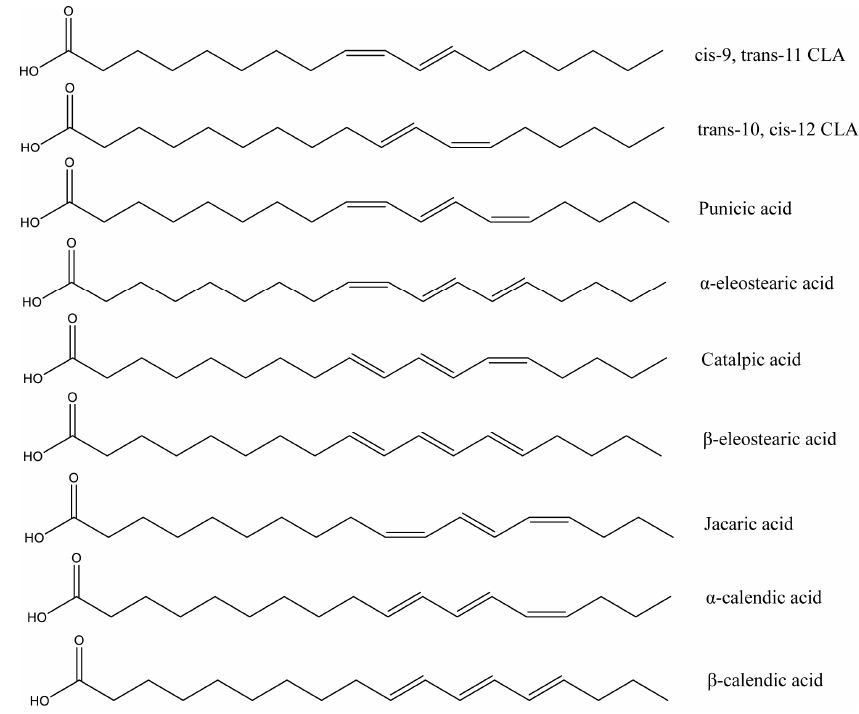
Figure 3. Structure of most abundant conjugated linoleic acids (CLAs) and conjugated linolenic acids (CLNA).